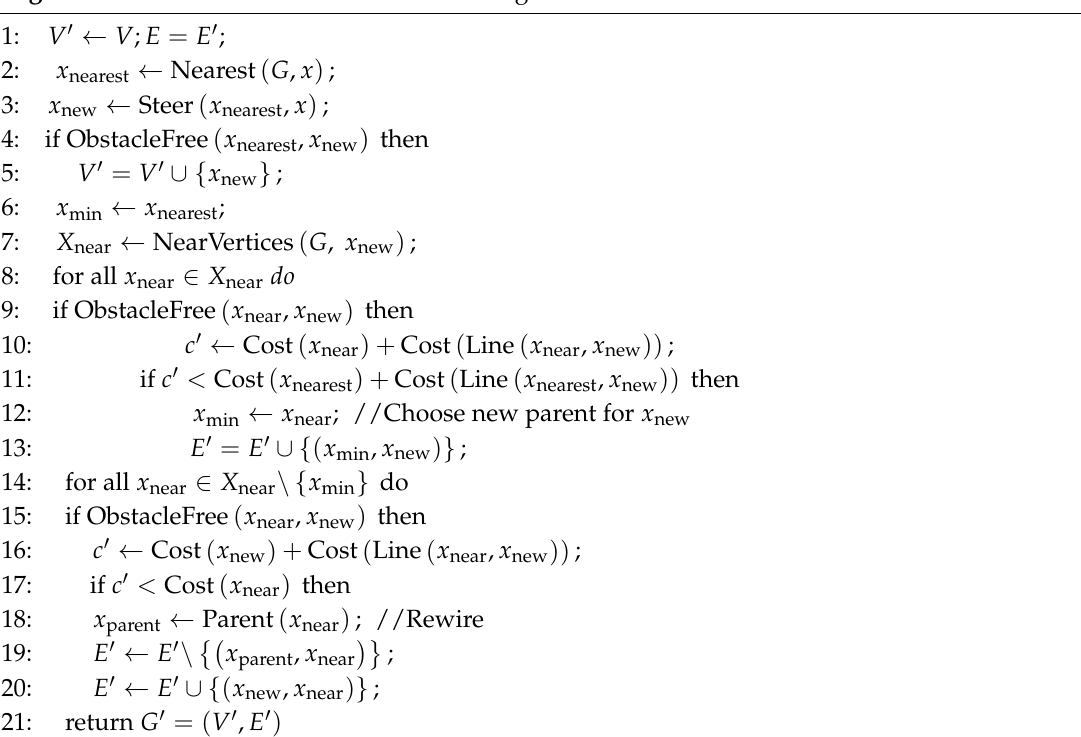
Algorithm 4: Extended function of the RRT*